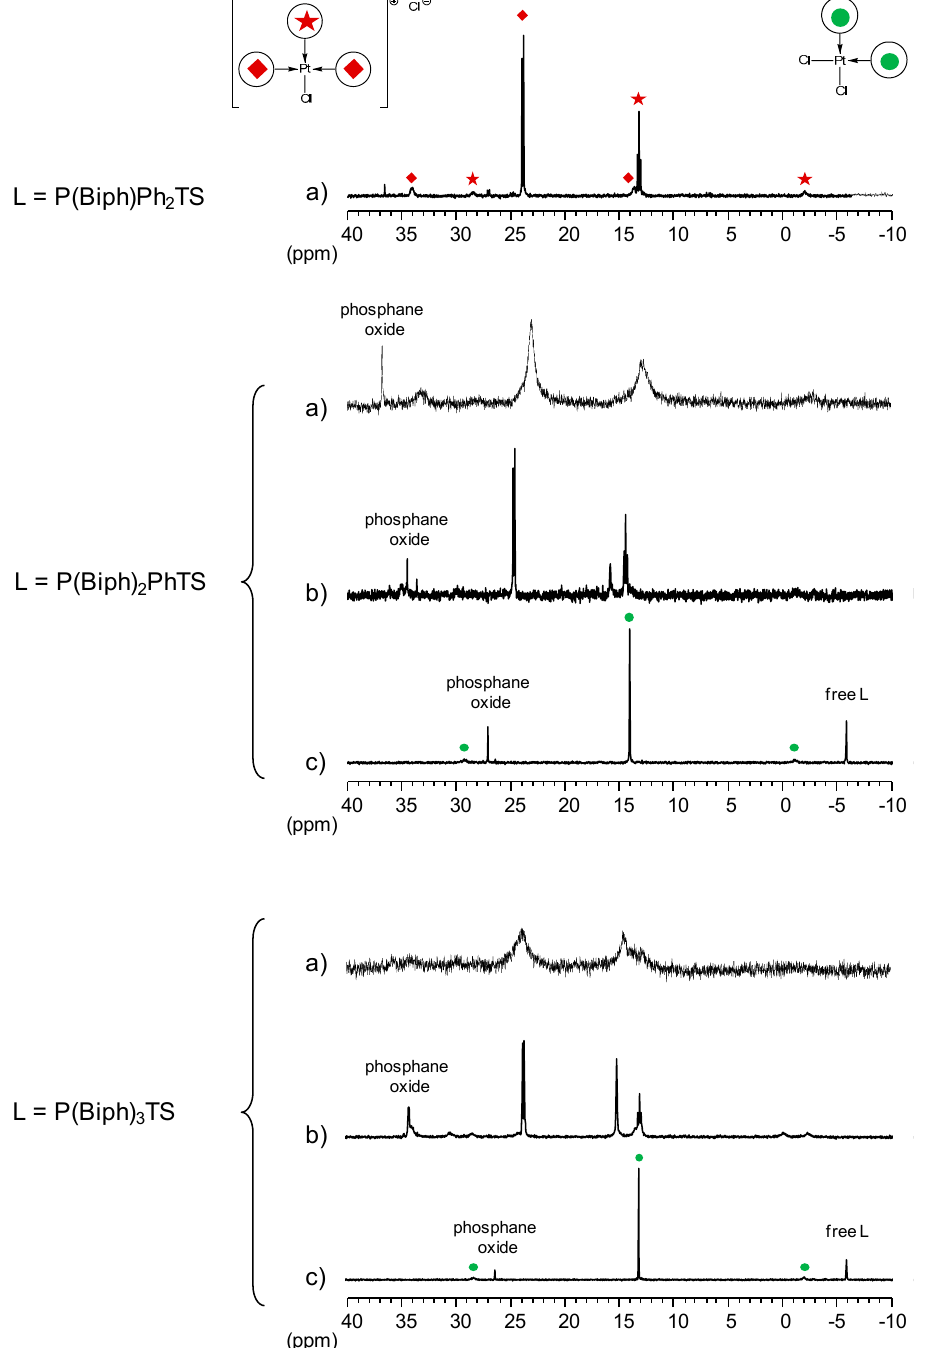
Figure 5. 31 P{ 1 H} NMR spectra of K 2 PtCl 4 solution (10 mM) + 3 equiv. of ligand (L) at 25 °C ( a ) in D 2 O ( b ) in D 2 O/DMSO- d 6 mixture (50/50 vol.) ( c ) in DMSO- d 6 .